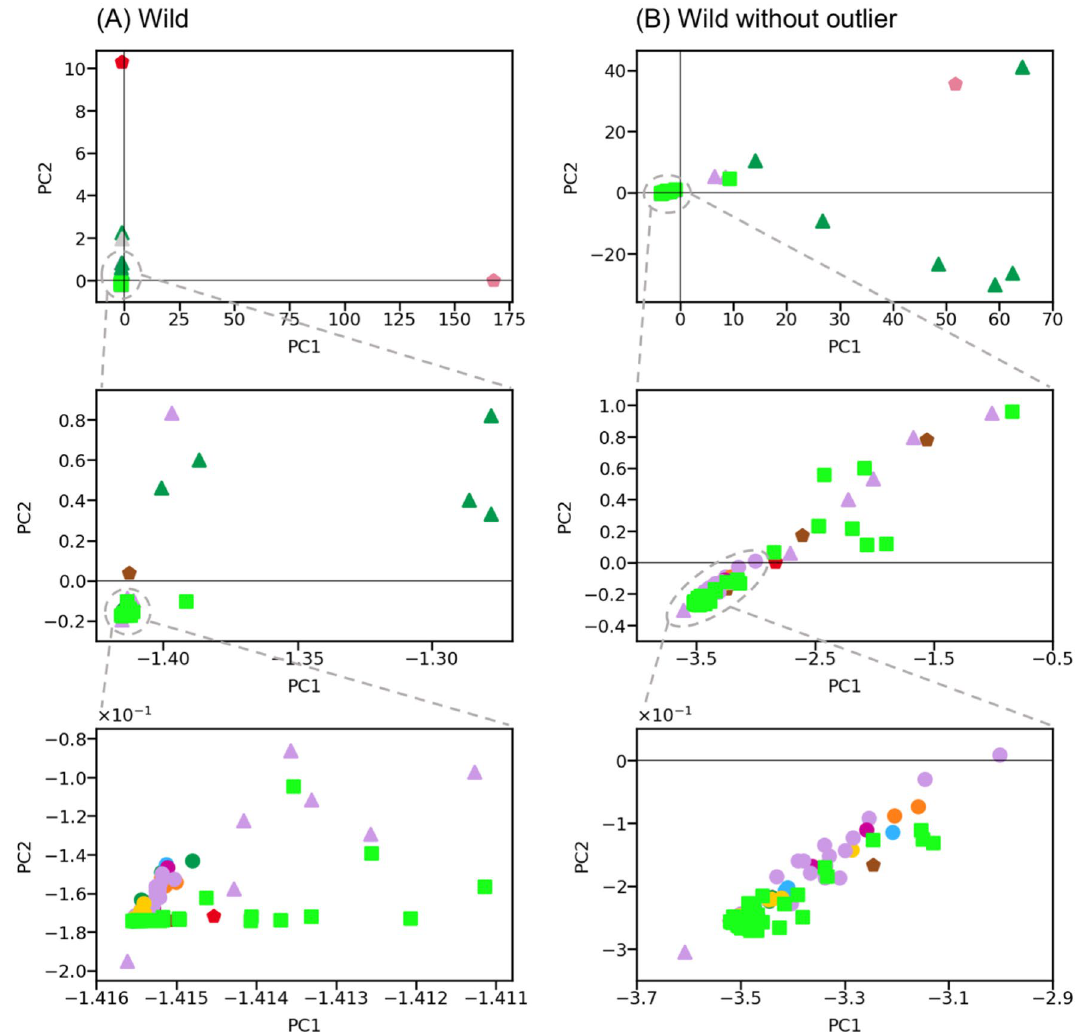
Figure 3. PCA results for the wild mouse data. Projection of the first (PC1) and the second (PC2) principal components of the immune measures (A) with and (B) without the outlier (number of spleen cells), with three levels of expansion (shown by the dotted lines) to reveal detail. Nodes are coded as in Fig.